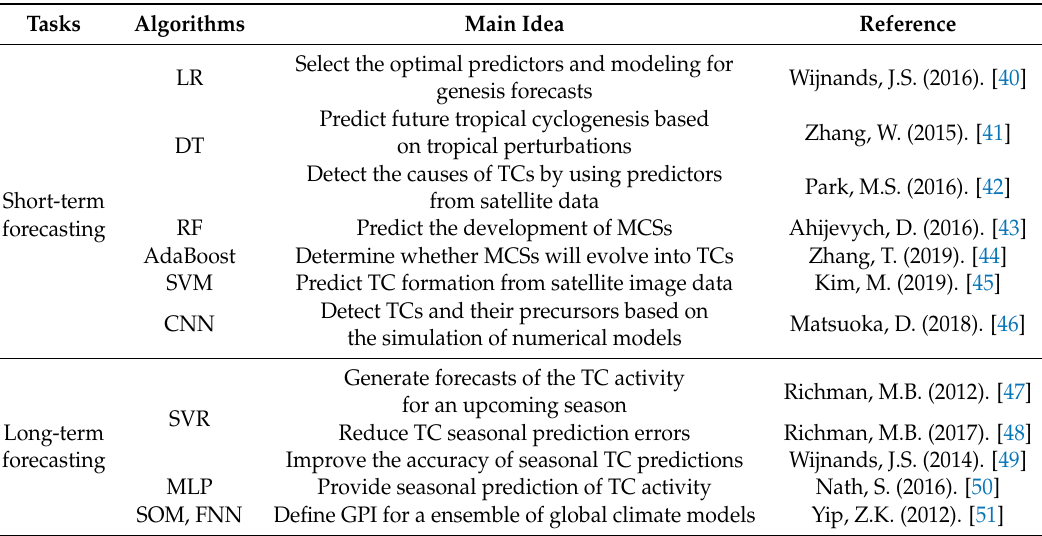
Table 1. Machine learning in tropical cyclone (TC) genesis